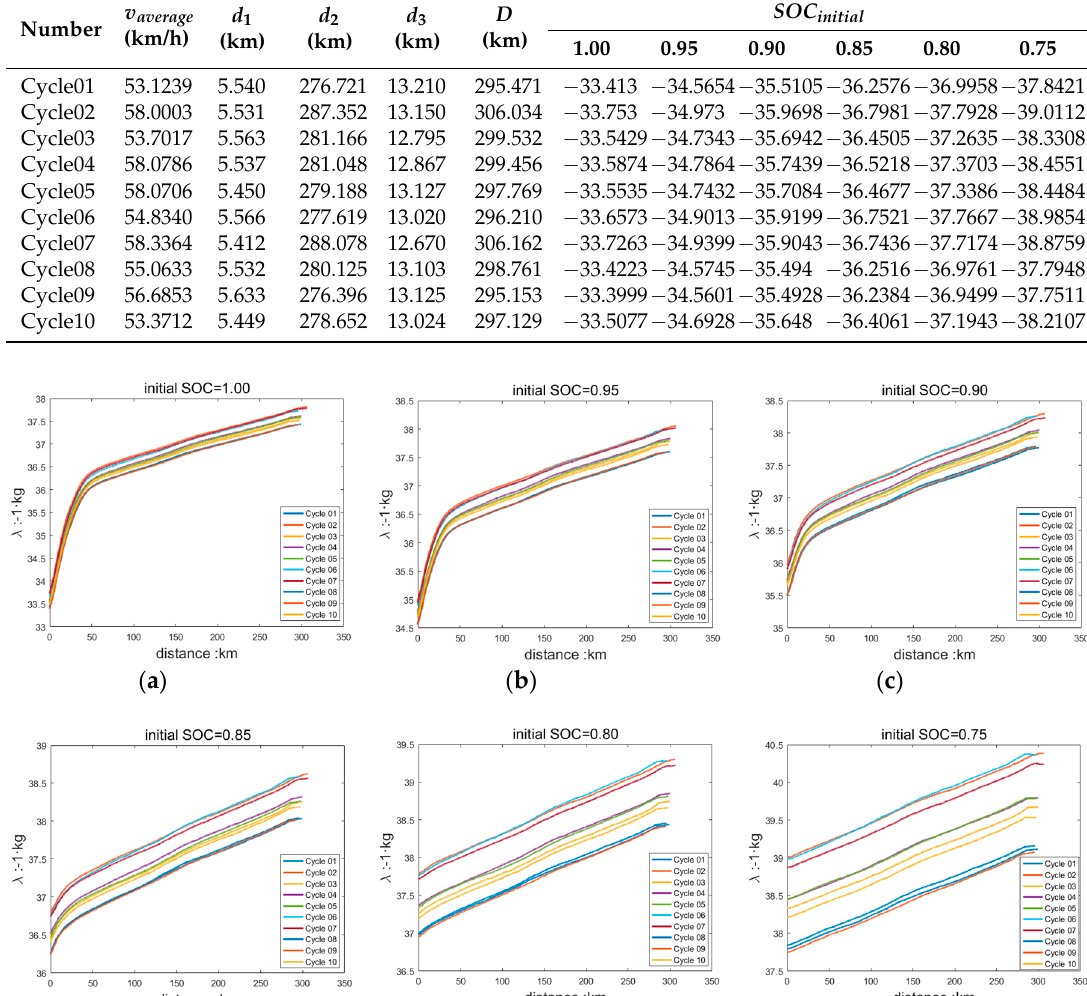
Table 4. λ 0 solving results and statistical data of 10 cycles.